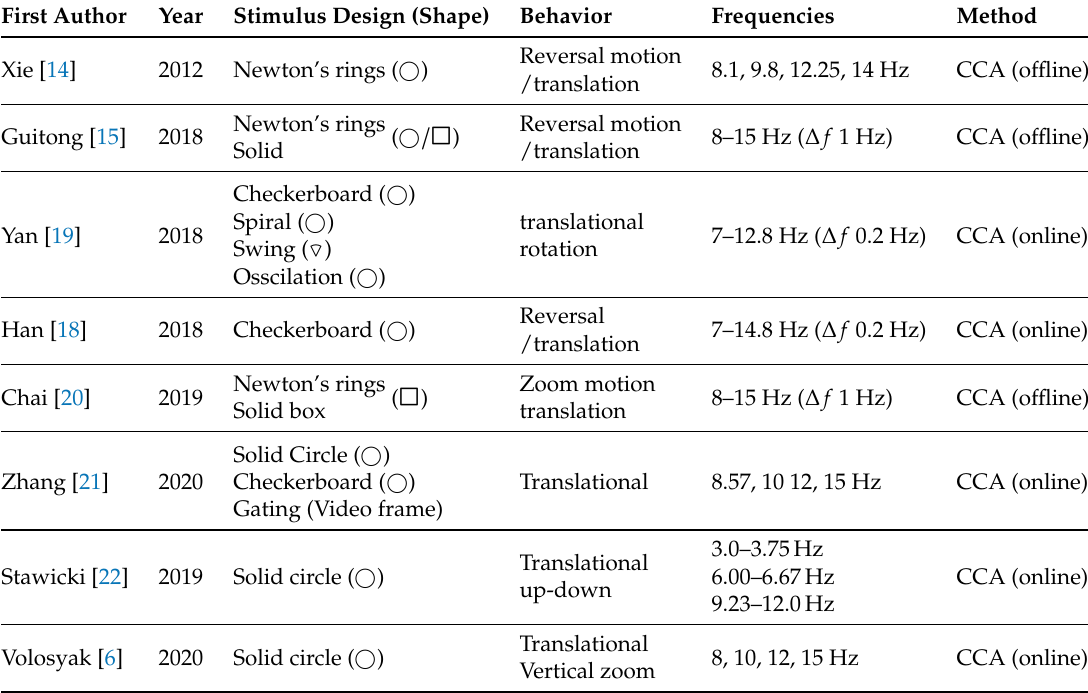
Table 1. Recent studies implementing motion-based visual evoked potentials (VEP)